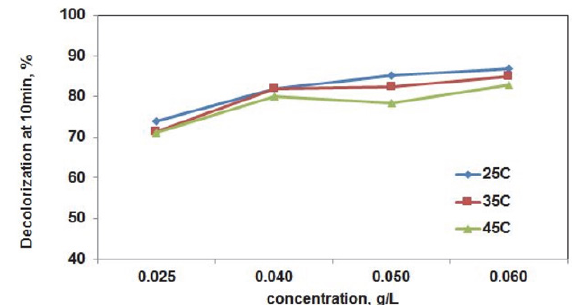
Fig. 7. Effect of initial dye concentration on the decolorization of DB-22 (pH: original, initial temperature: 25 °C, H 2 O 2 amount: 2.78 g/L, m-ZZF amount: 3 g/L, CaCl 2 amount: 3.75 g/L, UV